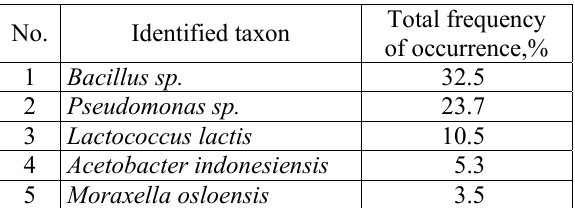
Table 6. Percentage of the grown colonies of microorganisms in the FPA and Giss medium